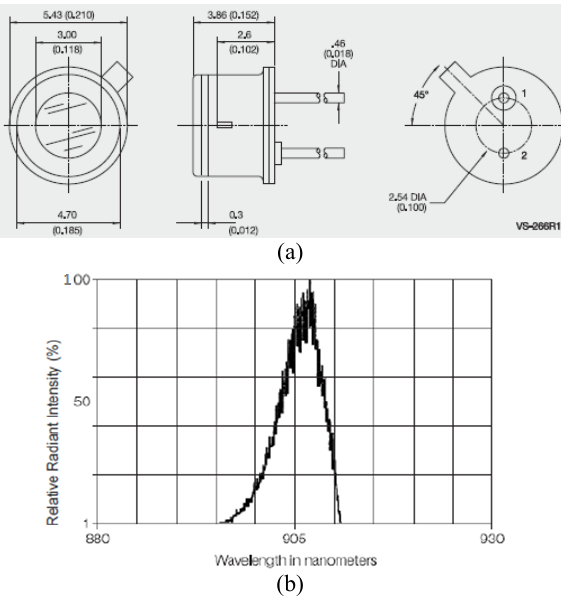
Figure 5. (a) Package drawing and (b) its spectral plot distribution ( http://www.perkinelmer.com/ DiodesforRange Finding.pdf)